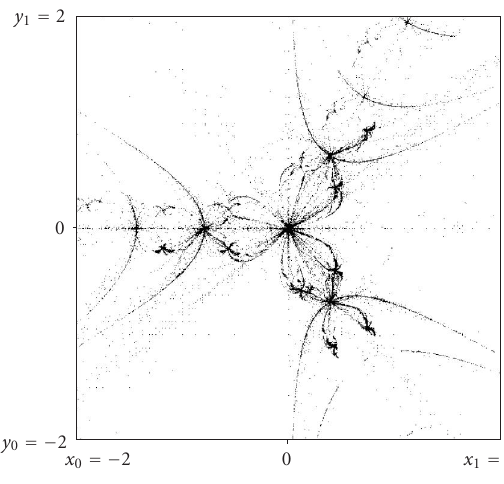
Figure 6.3. Third generation of Julia